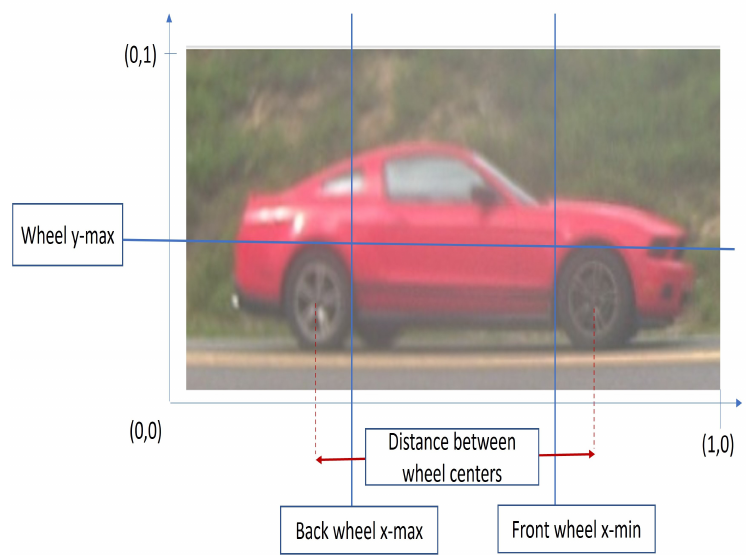
Figure 5. The measures utilized in our approach; y-axis coordinate, back wheel location, front wheel location, and the distance between wheel centers.